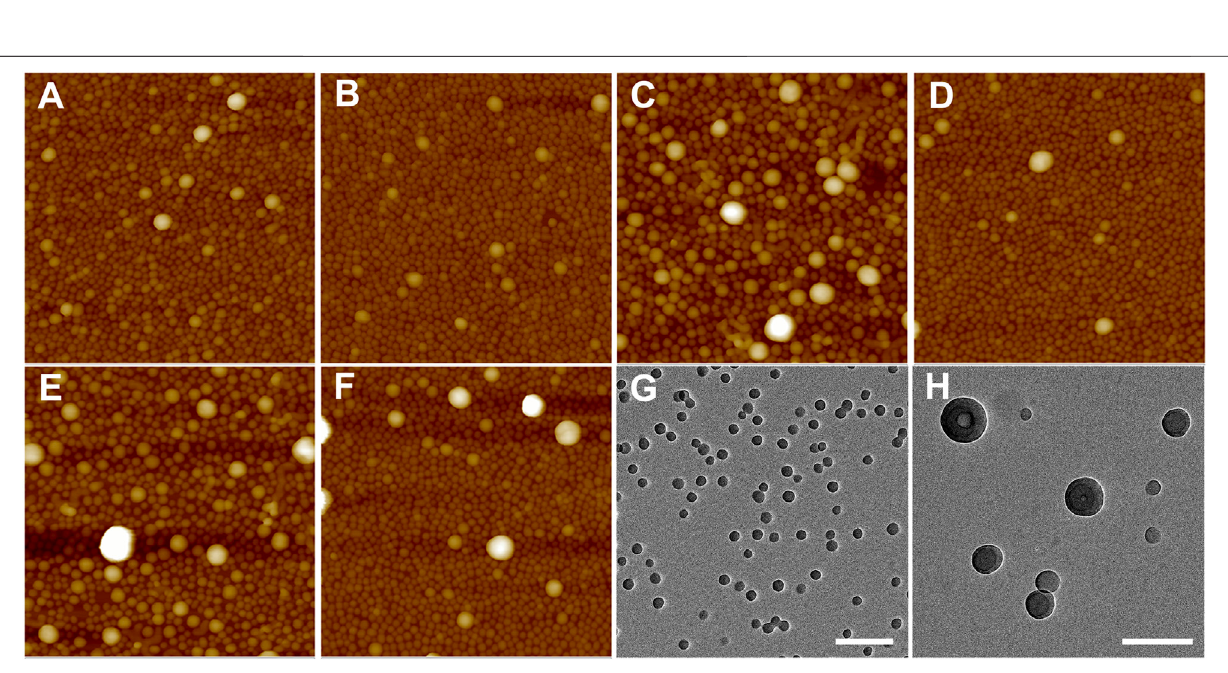
mixtures, the NP size for the premixed blend (D2S5-1) is larger than that for the postmixed systems (D2S5-2). In addition, the NP shapes for these two blends are different, as re fl ected in the AFM